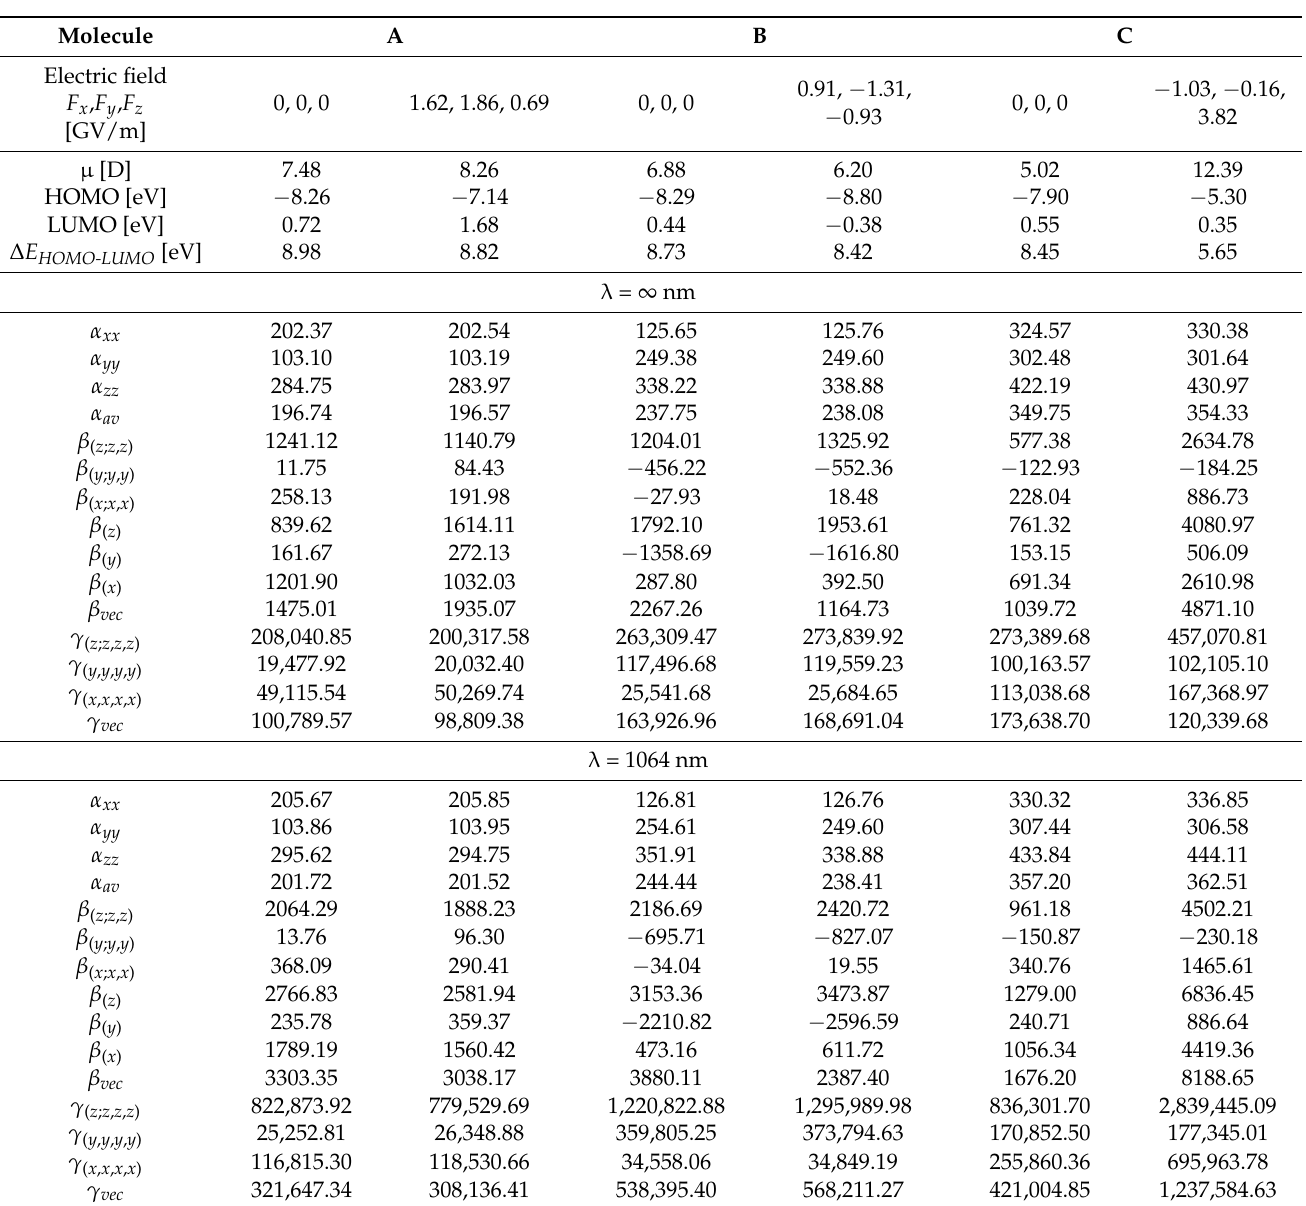
Table 2. Electric and optical properties of the A, B, and C molecules calculated in vacuum ( F x , F y , F z = 0,0,0) and in the PVK polymer environment ( F x , F y , F z (cid:54) = 0,0,0) in volumetric form by using the TDDFT method applying the GGA/B3LYP